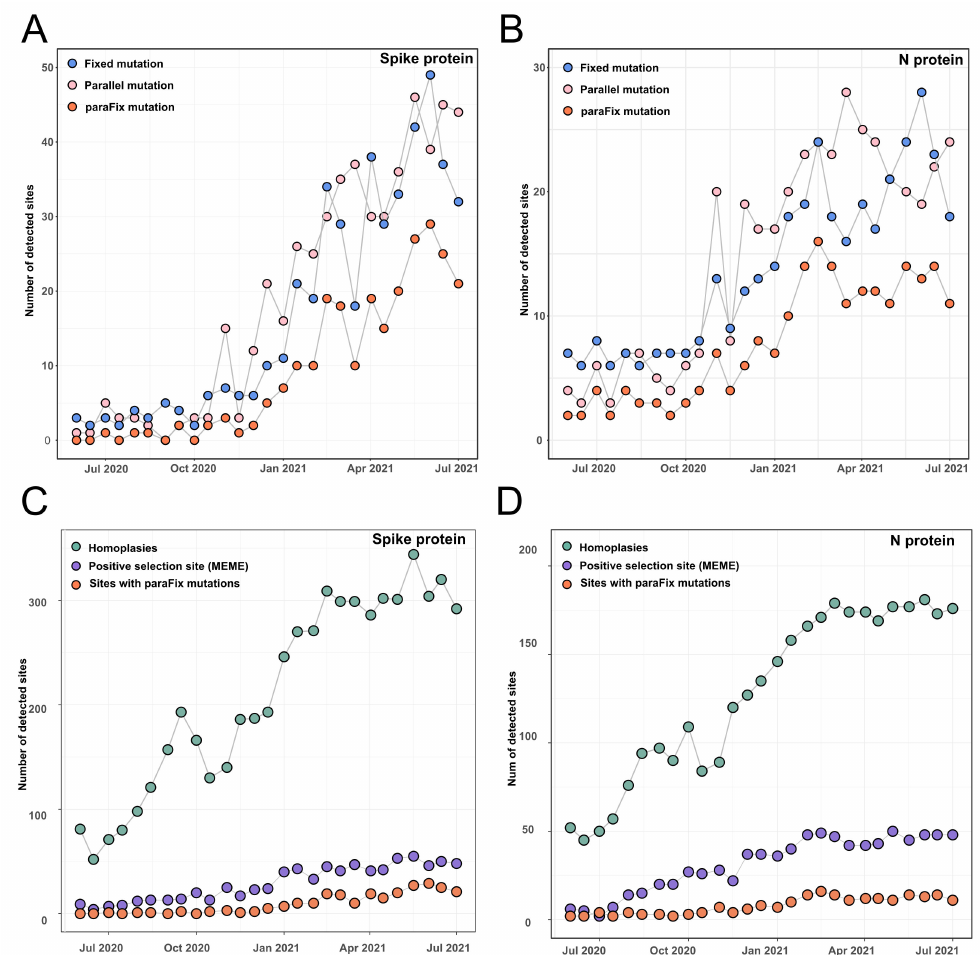
Figure 2. Comparison of identified sites with paraFix mutation for SARS-CoV-2 against positive selection sites and homoplasies. ( A , B ) The number of detected sites accumulated with time by considering fixed mutations, parallel mutations, and paraFix mutations in Spike protein ( A ) and N protein ( B ) of SARS-CoV-2. ( C , D ) The number of detected sites accumulated with time by considering homoplasies, positive selection sites (inferred with MEME in HyPhy), or paraFix mutation in S protein ( C ) and N protein ( D